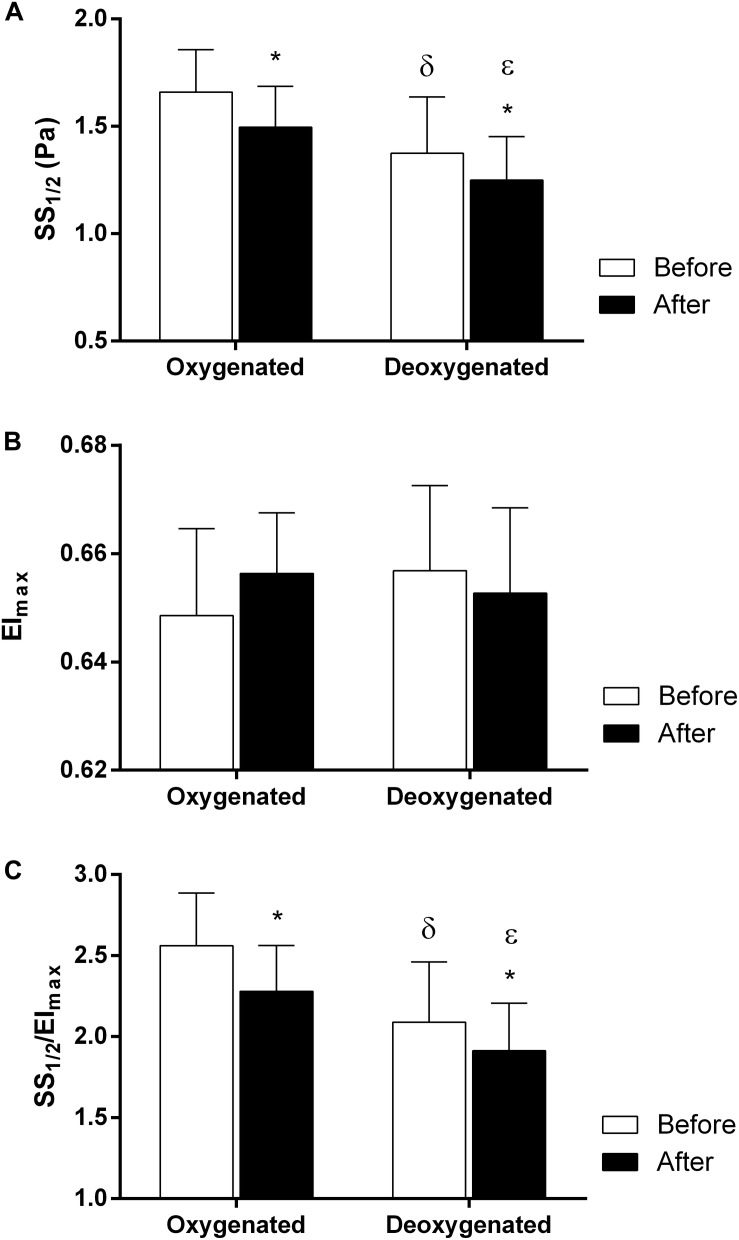
Maximal elongation and half shear stress parameters. Data is collected from 10 different subjects with two replicative measurements and presented as mean ± standard deviation (SD). SS1/2
(A), EImax
(B), SS1/2/EImax
(C) parameters in oxygenated and deoxygenated conditions before and after 5 Pa SS application. ∗p < 0.05 (The difference between before and after SS), δp < 0.001 (The difference in SS1/2 values between oxygenated and deoxygenated conditions), εp < 0.0001 (The difference in SS1/2/EImax values between oxygenated and deoxygenated conditions before SS).